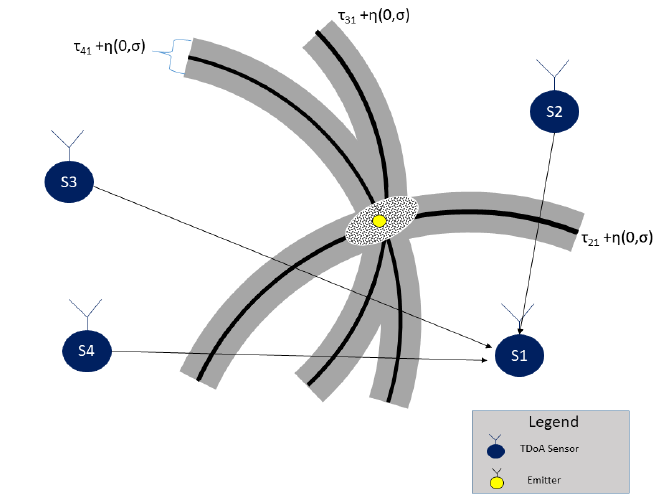
Figure 2. Location error caused by multipath situation in TDOA